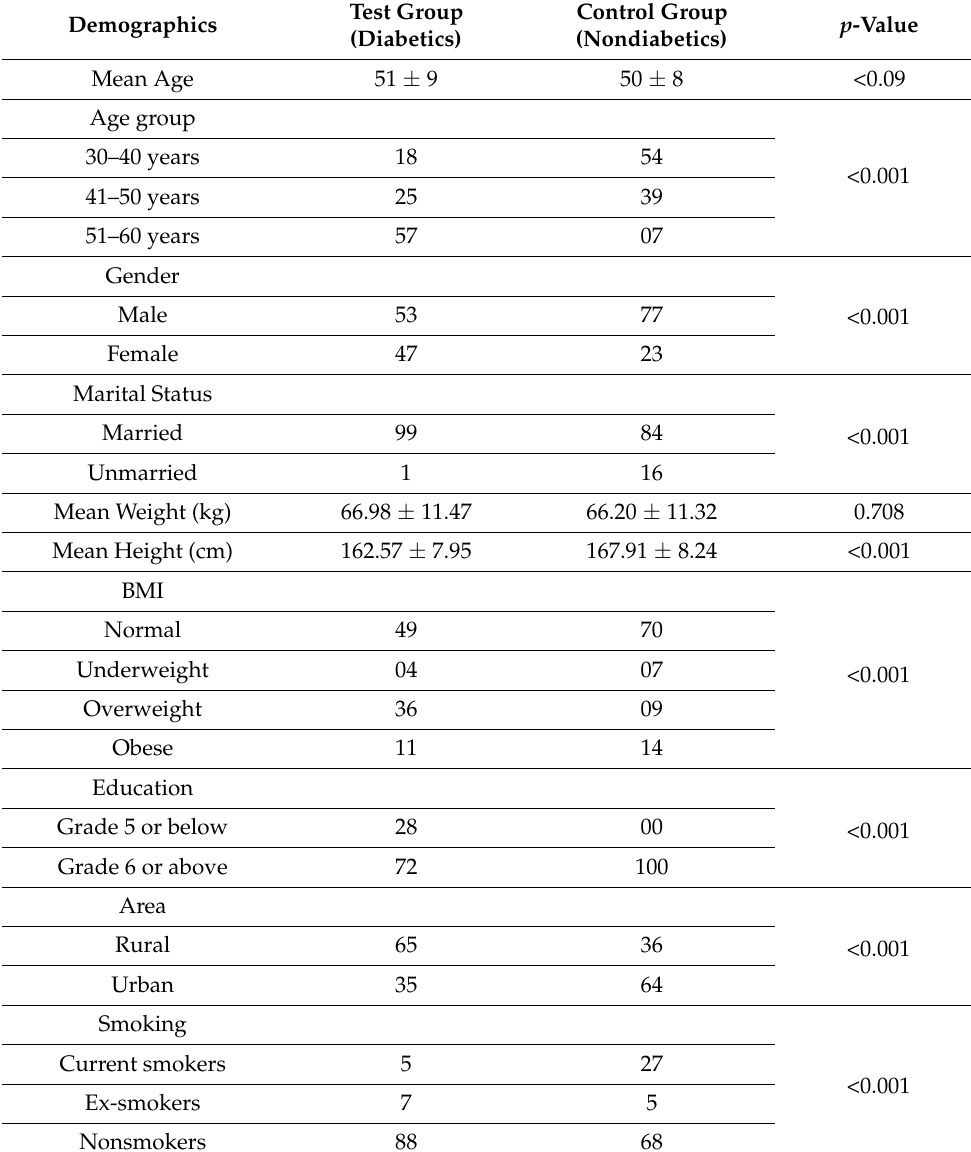
Table 1. Sociodemographics of participants in the test and control groups.